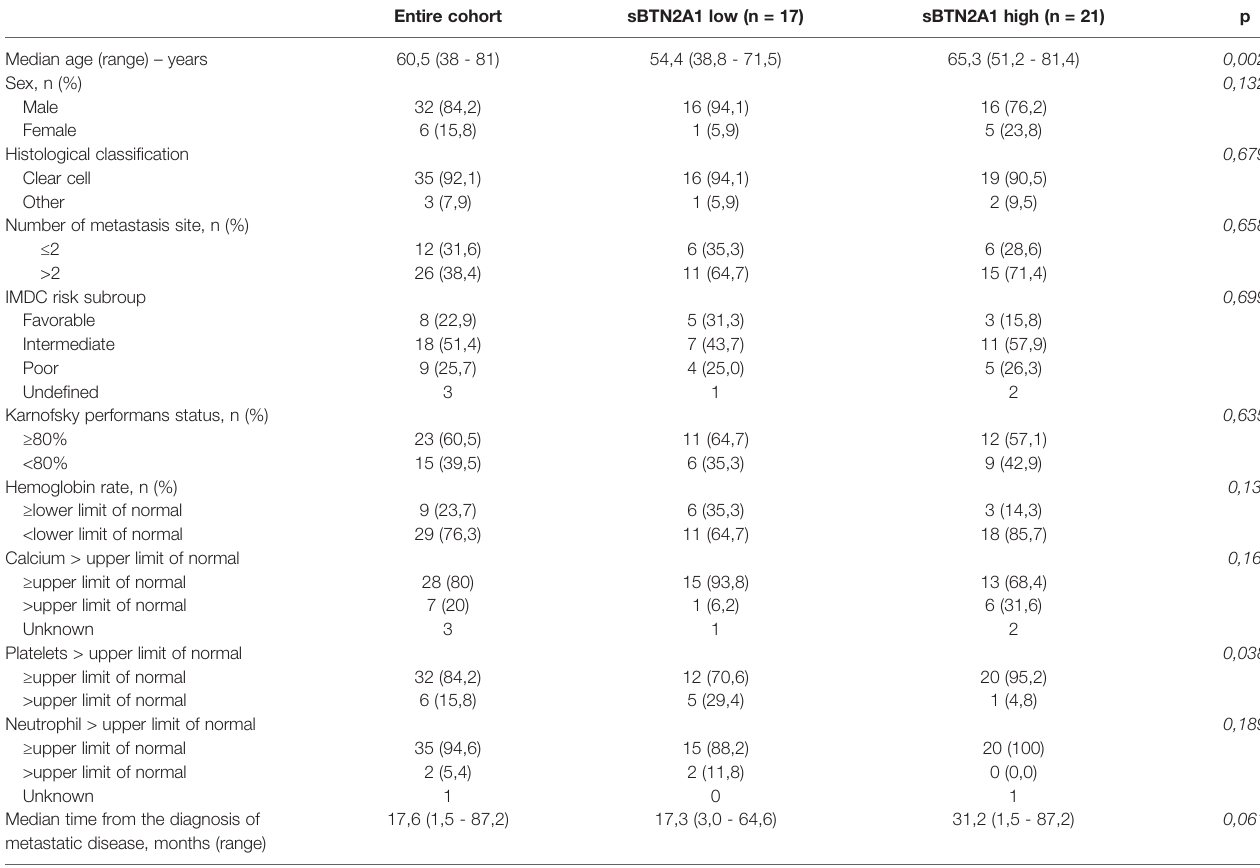
TABLE 1 | Baseline characteristics (n =